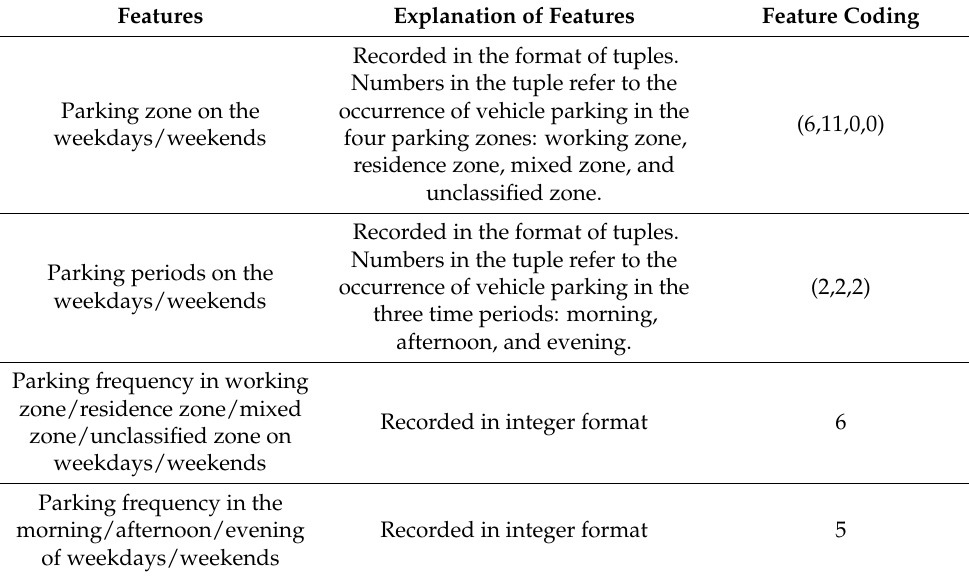
Table 1. Description of 18 spatiotemporal parking features and coding used for the